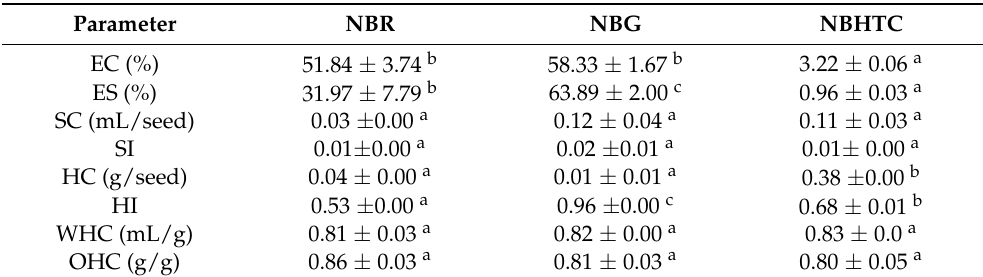
Table 5. The functional properties of raw, germinated, and hydrothermally cooked Nitta beans flours (g 100 g − 1